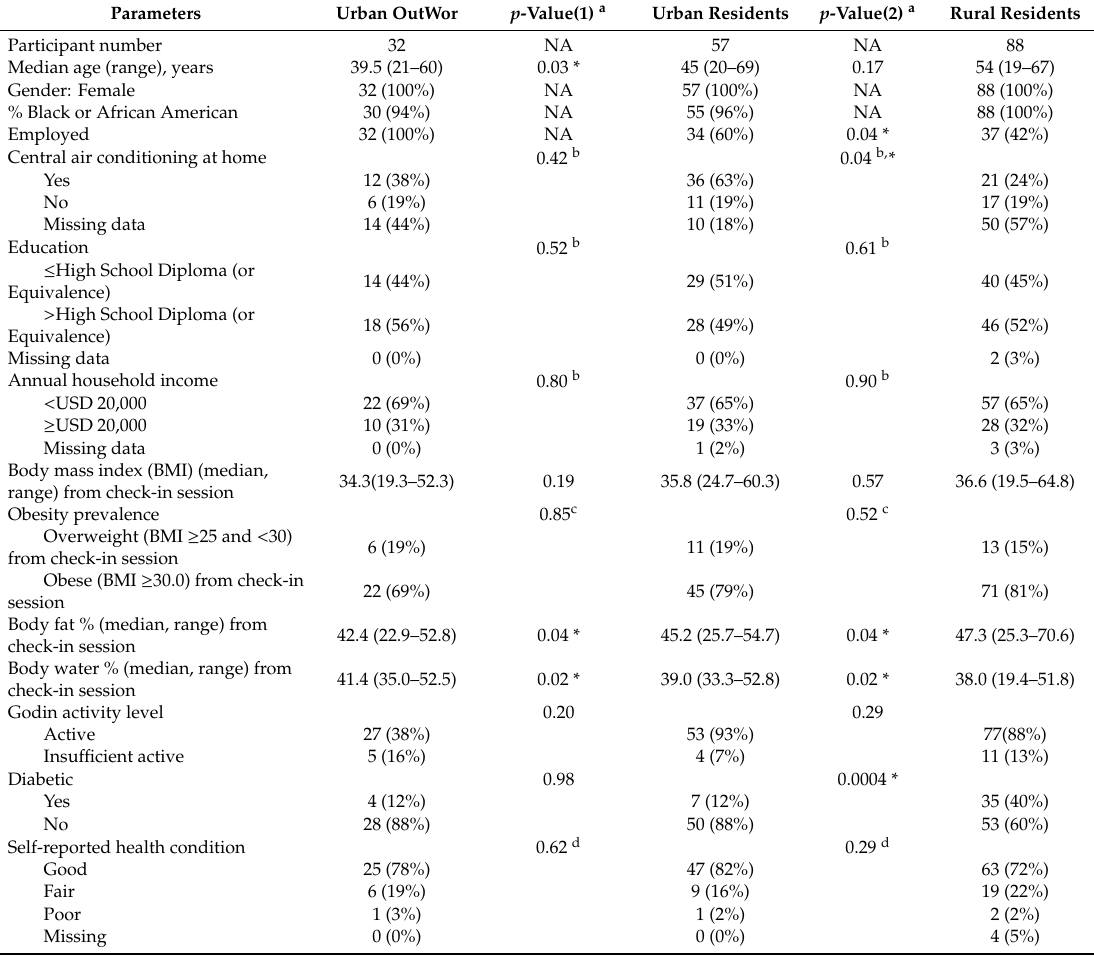
Table 1. Participant demographics and